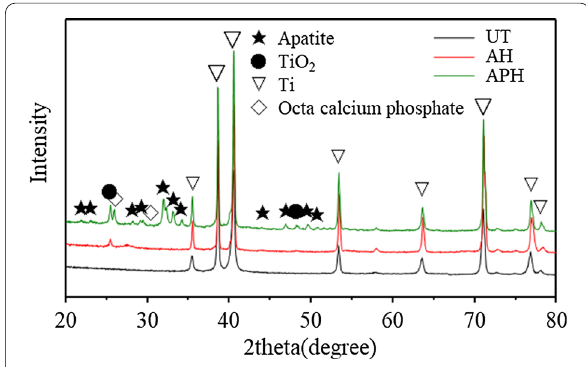
Fig. 4 X‑ray diffraction patterns of Ti–6Al–4V ELI alloy plate specimens for the UT, AH, and APH